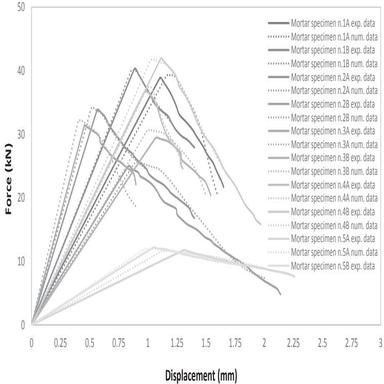
Comparison between the experimental and numerical results from the optimization process with the Levenberg-Marquardt algorithm for the load bearing test on mortar.